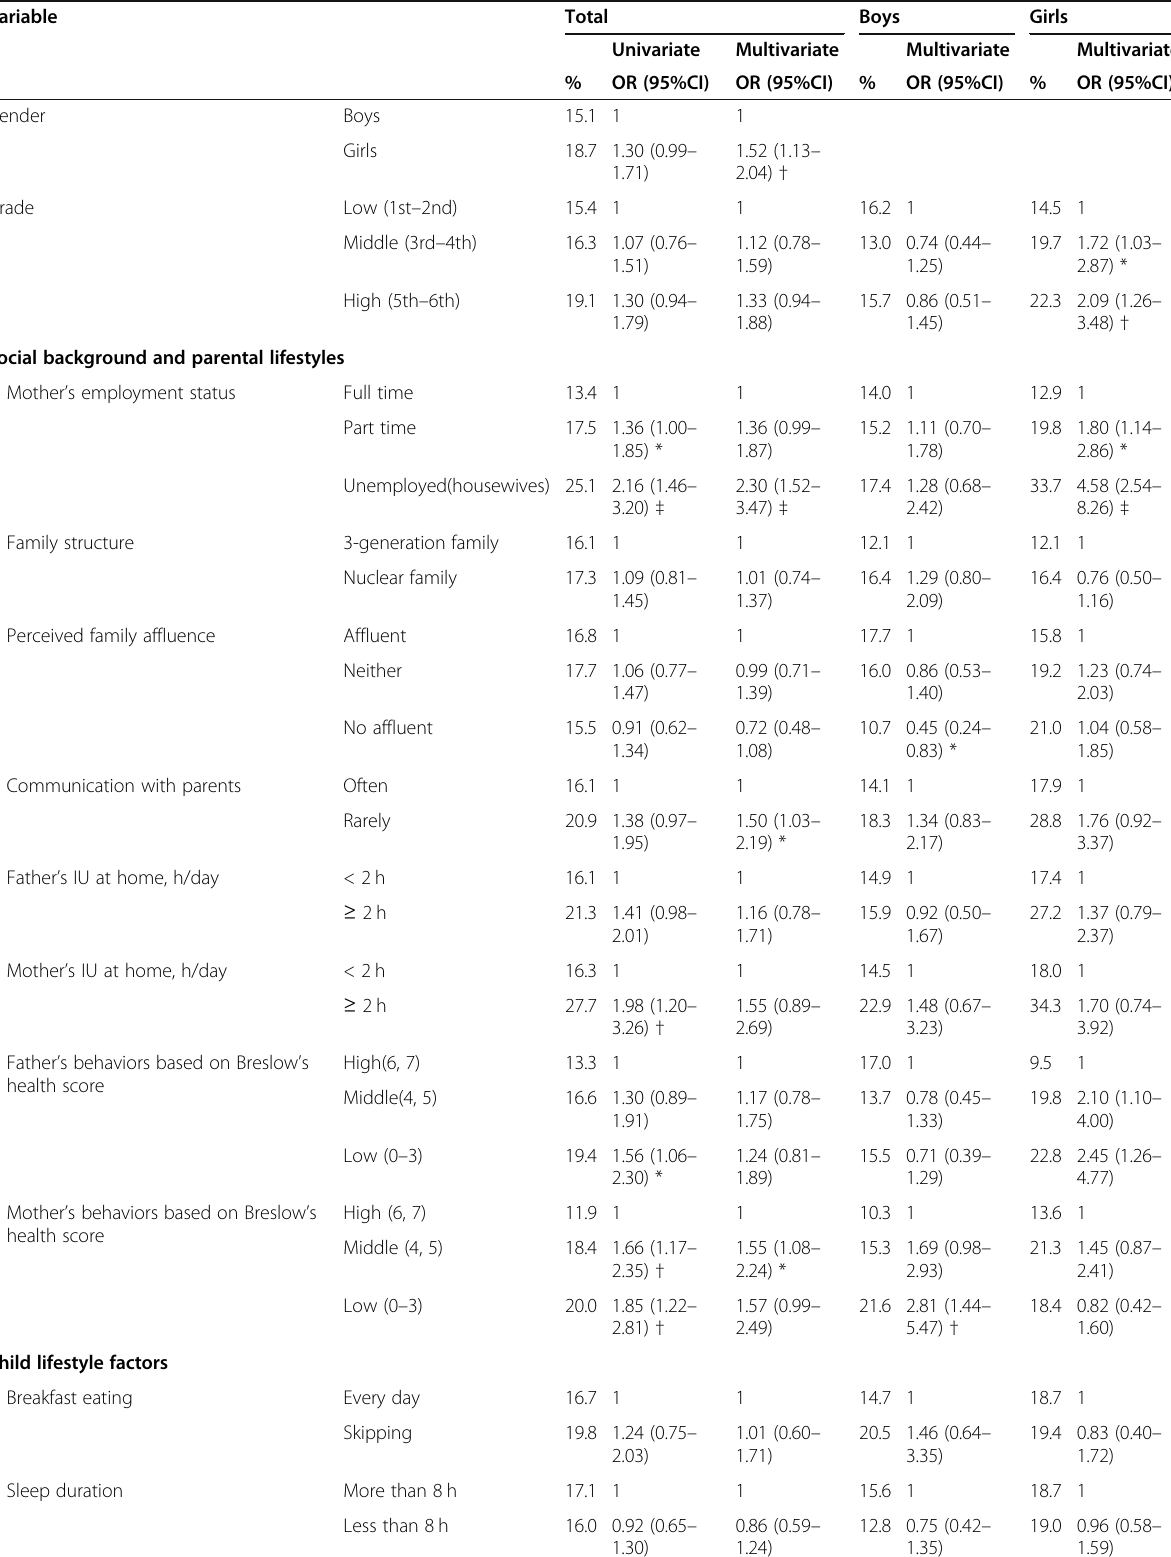
Table 4 Logistic regression analysis results for “ Lack of physical activity ” regardless of “ Prefer physical activity ” ( n = 1486)